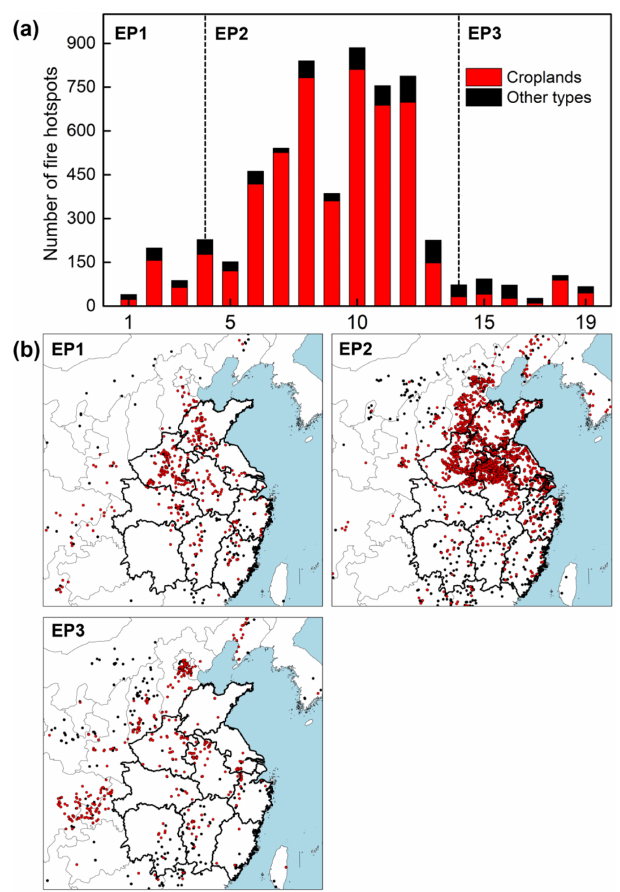
Figure 3. (a) Temporal and (b) spatial variations in the number of fire hotspots for OCSB and other types of OBB during EP1, EP2, and EP3, which represent three successive episodes in turn, namely from 1–4, 5–14, and 15–19 June, respectively. The maps were cre- ated by NCAR Command Language (NCL) (http://www.ncl.ucar. edu/, last access: 18 December